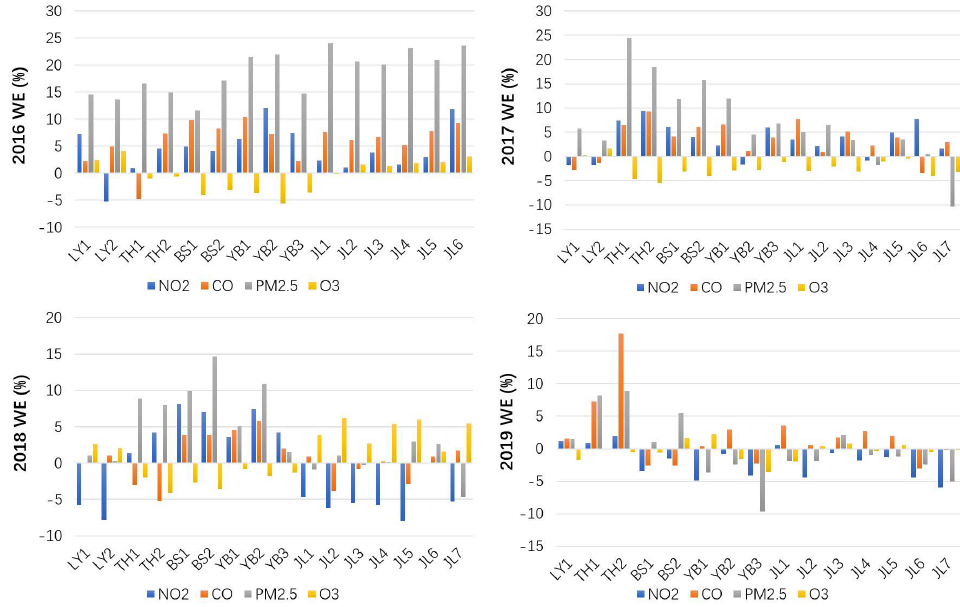
Figure 13. Weekend effect index of four pollutants at each station in 2016–2019.